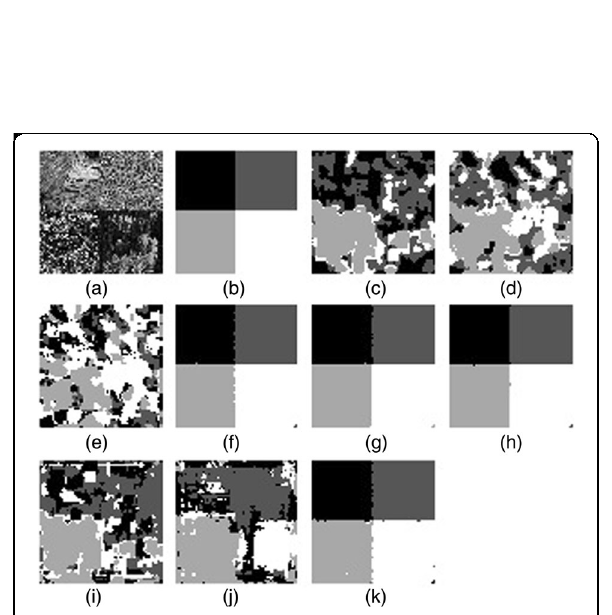
Fig. 28 Segmentation results for the previous mosaic in presence of Gaussian noise with density of 0.3. a Original image. b Hand- segmented image. c Gaussian features. d Rayleigh features. e Alpha- stable features. f Gaussian + contourlet features. g Rayleigh + contourlet features. h Alpha-stable + contourlet features. i Fractal dimension. j Fractal + contourlet. k Alpha-stable +